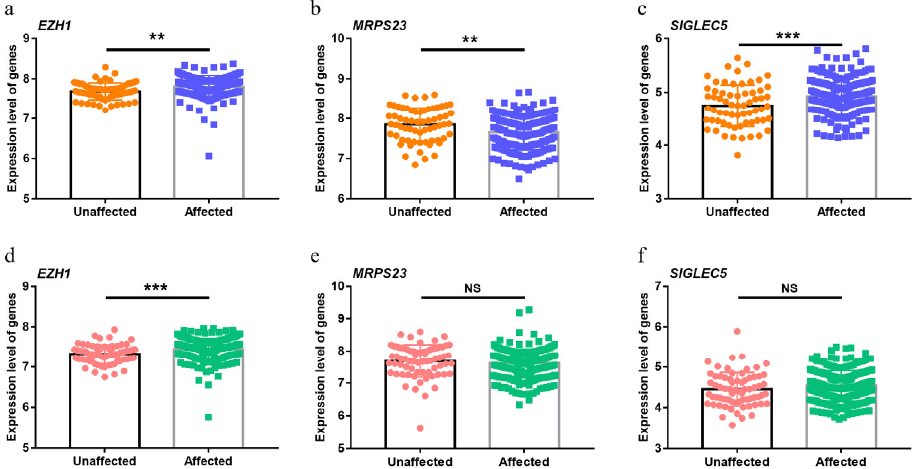
Figure 4. Dysregulation of top causal genes in periodontitis. Differentially expressed genes in the affected and unaffected gingival tissue sites among periodontitis patients. Data from GSE10334 ( a – c ) and GSE16134 ( d – f ). EZH1 was significantly upregulated in the periodontal ligament in periodontitis sites compared with unaffected sites. NS, p > 0.05; ** p < 0.01; *** p < 0.001.